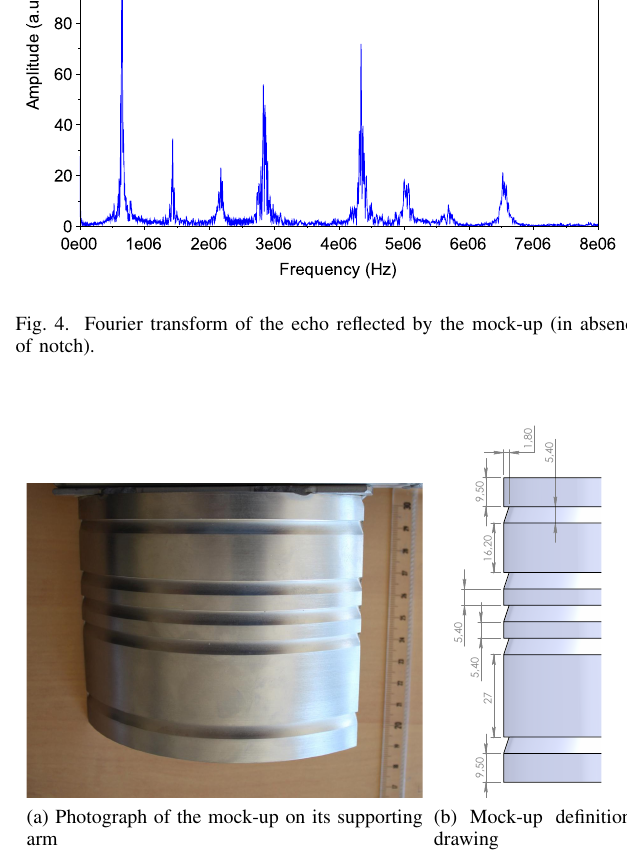
Fig. 5. Sodium experiment mock-up.